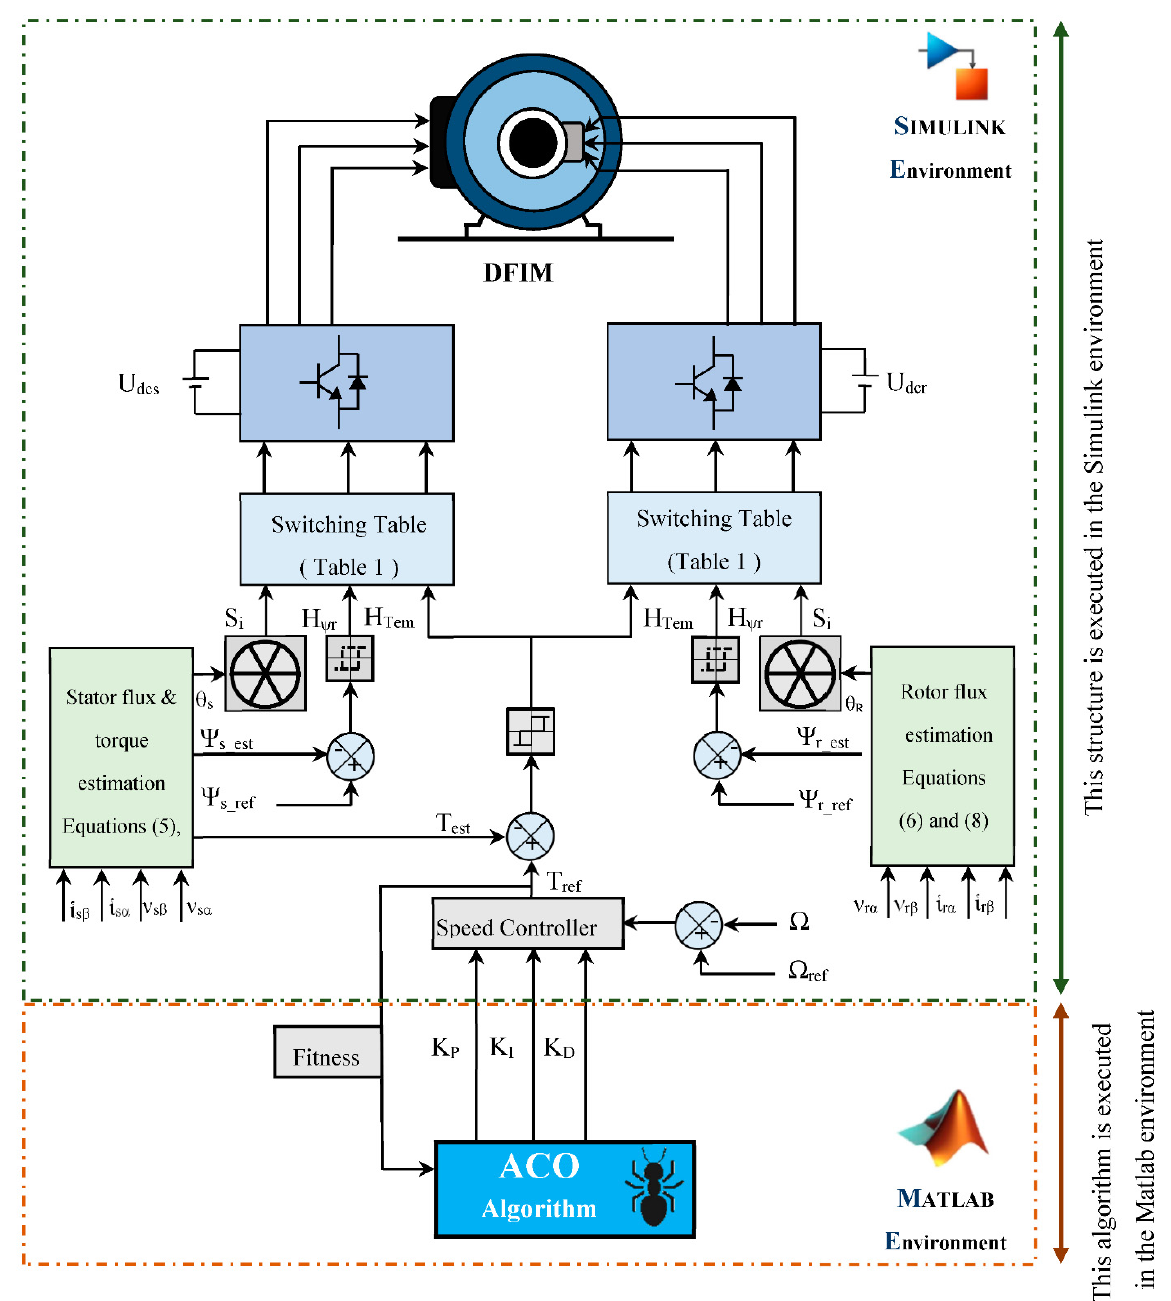
Figure 10. Global proposed ACO-DTC structure applied to